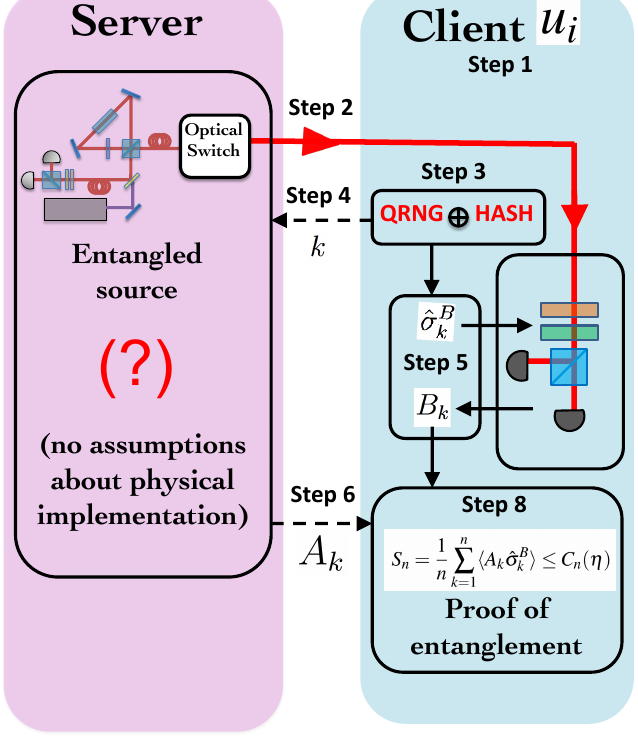
Fig. 3. The PoE mining protocol, undertaken between a quantum server and client . Pur- ple shading (left-hand side) indicates the initially untrusted quantum server. Blue shading (right-hand side) indicates the client, who assumes the validity of quantum physics and trusts their measurement apparatus. Dashed arrows indicate classical public communication, solid red arrows indicate quantum communication, and solid black arrows represent private clas- sical communication. Step numeration coincides with the steps of the PoE mining protocol outlined in the main text. In this example, the measurement device utilised by the client is assumed to perform polarisation measurements upon photonic